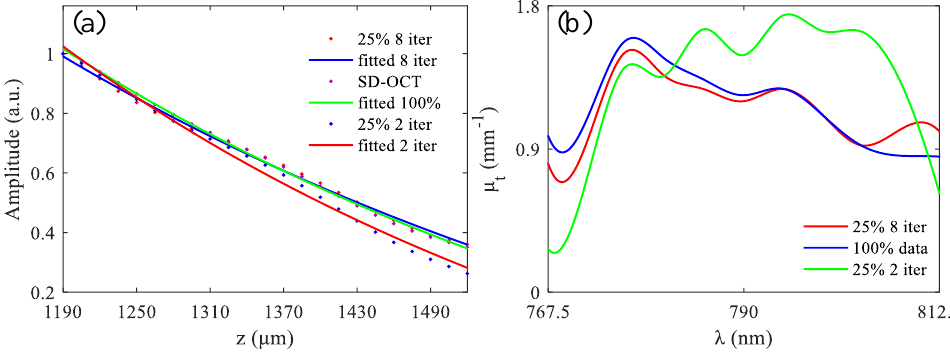
Figure 7. ( a ) The results of exponential fitting; ( b ) spectrums of the extinction coefficient. Next, several issues need to be